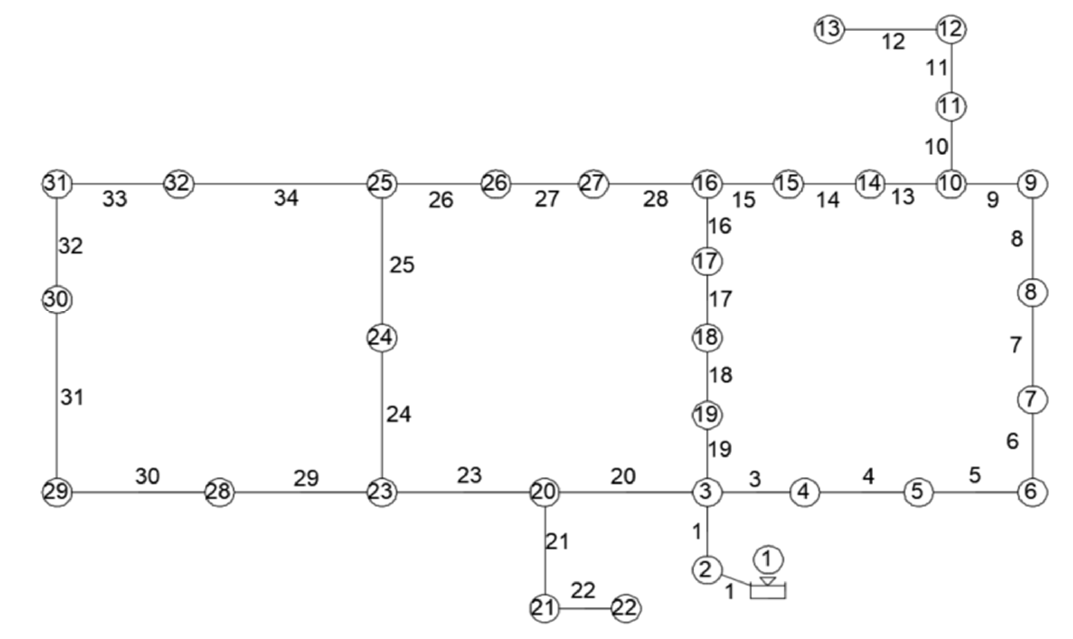
Figure 8. Layout of the Hanoi network. Table 6. Results for the Hanoi network.